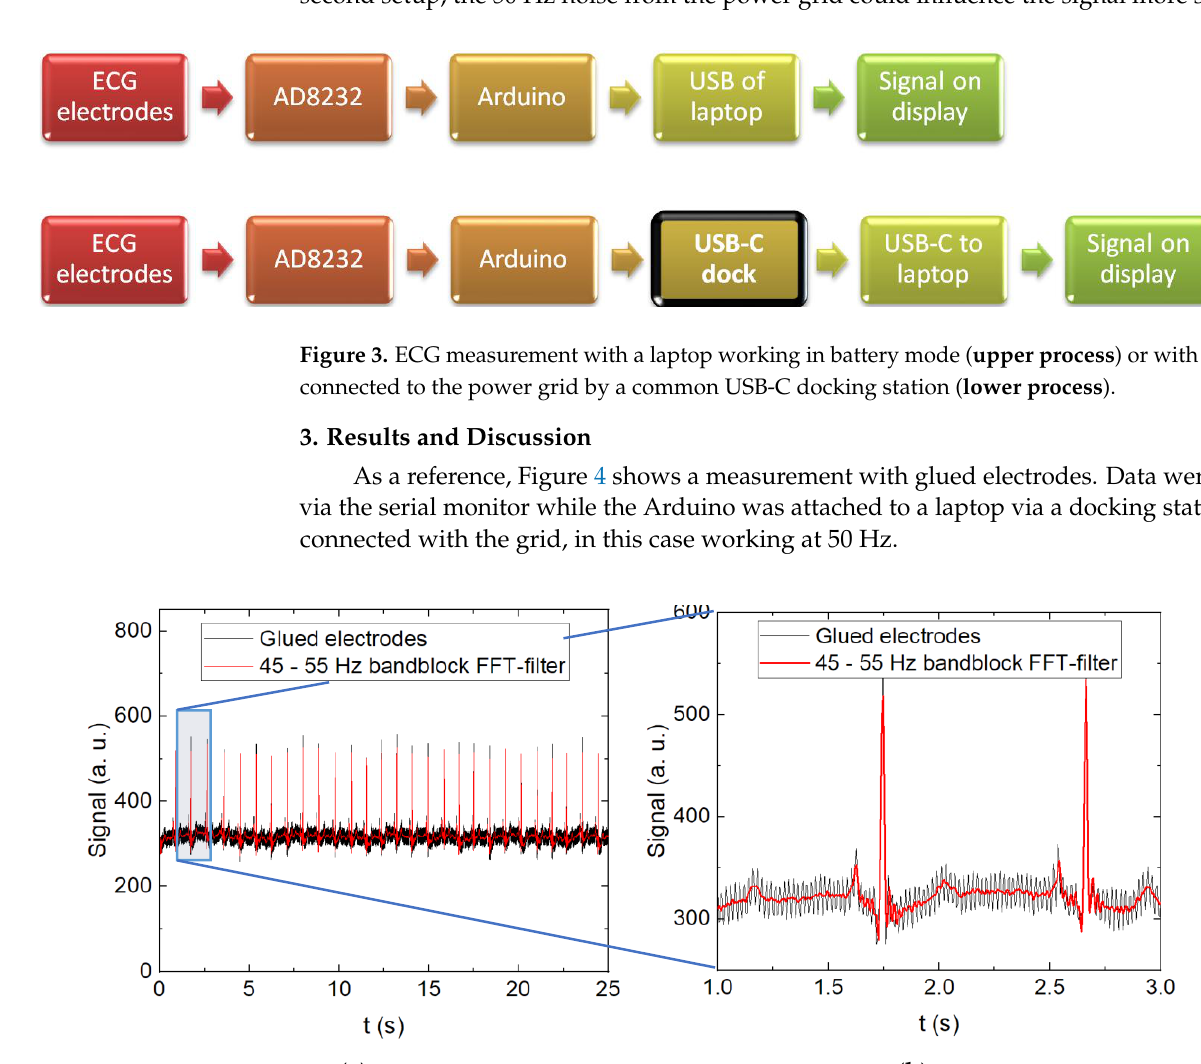
Figure 2. Textile electrodes used in this study: ( a ) electrode 8; ( b ) electrode 4.3; ( c ) electrode 4.2; ( d ) Powersil on cotton; ( e ) Ripstop Silver; ( f ) Shieldit Super; ( g ) sewn Shieldex; ( h ) PEDOT:PSS coating; ( i ) Tubicoat coating; ( j ) non-textile graphite foil. Yellow scale bars depict 1 mm.